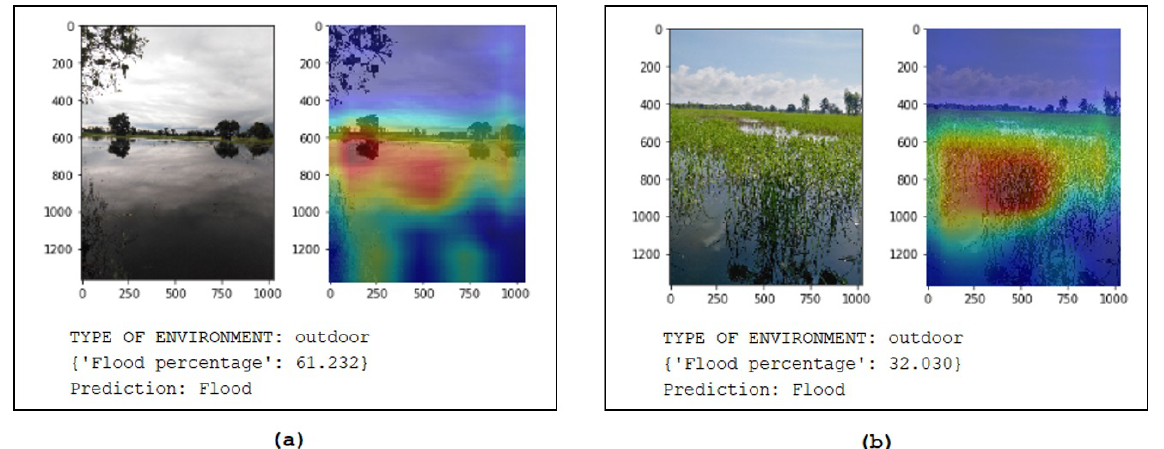
Figure 6. Samples of mobile photos, activation maps and predictions made from our decision-based method for flood detection. The heat map shown is an activation map used by the final layer of ResNet-18 of PlacesCNN to make its prediction. ( a ) Sample from the severely flooded region. ( b ) Sample from the moderately flooded